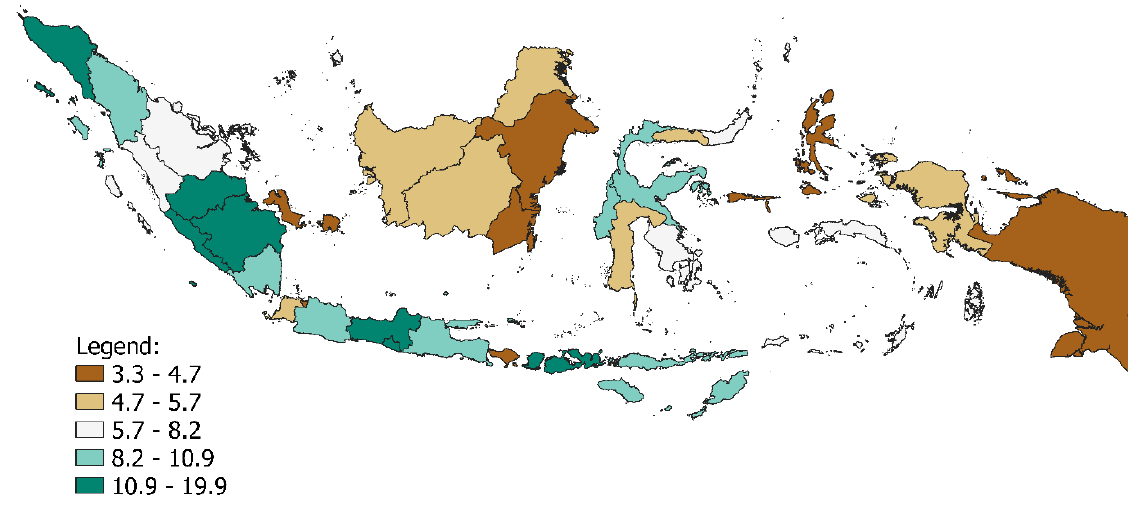
Figure 3: The Average Distribution of Poor People in 34 Provinces in Indonesia, 2010-2018 (%)